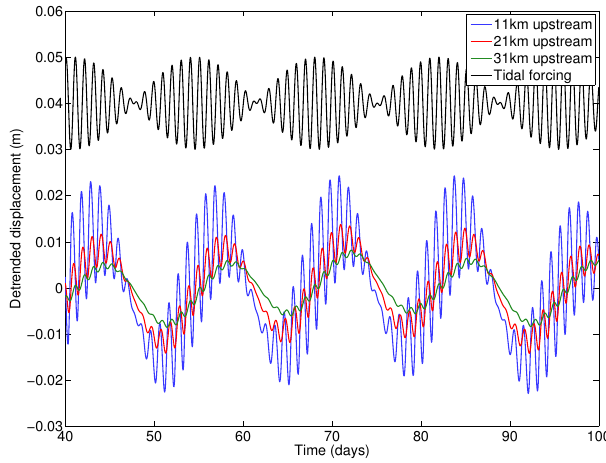
Figure 3. Detrended in-line displacements at 11, 21 and 31km up- stream of the grounding line for the 3-D model run using an ide- alised Siple coast geometry. The tidal forcing is also shown, scaled down by a factor of 100 and shifted